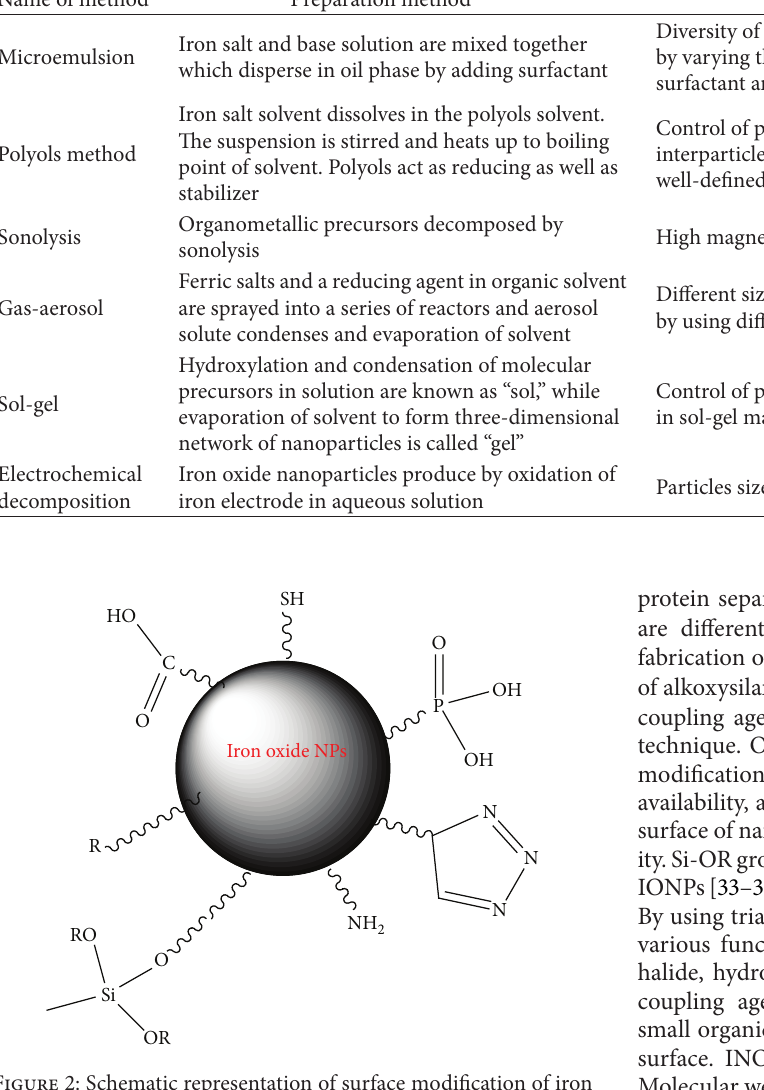
Figure 2: Schematic representation of surface modification of iron oxide